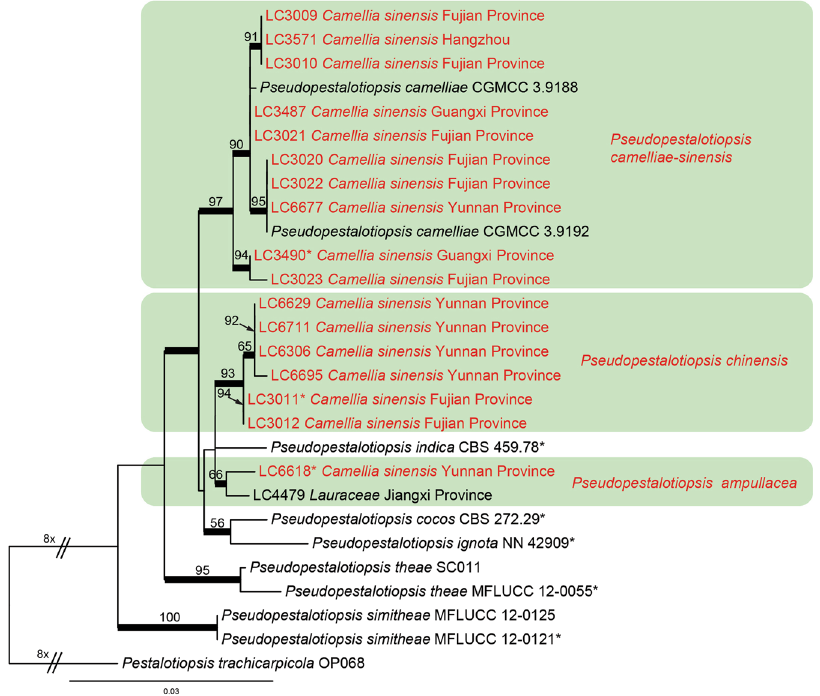
Figure 5. Phylogenetic tree of Pseudopestalotiopsis calculated with maximum likelihood analysis on a combined dataset of three-locus sequences (ITS, TUB2, TEF) by running RAxML v.7.0.3. The RAxML bootstrap support values ( > 50%) are displayed at the nodes. Thickened branches indicate branches also present in the Bayesian tree with > 0.95 posterior probabilities. Stars indicate ex-type cultures. Strains from Camellia spp. in this study are in red